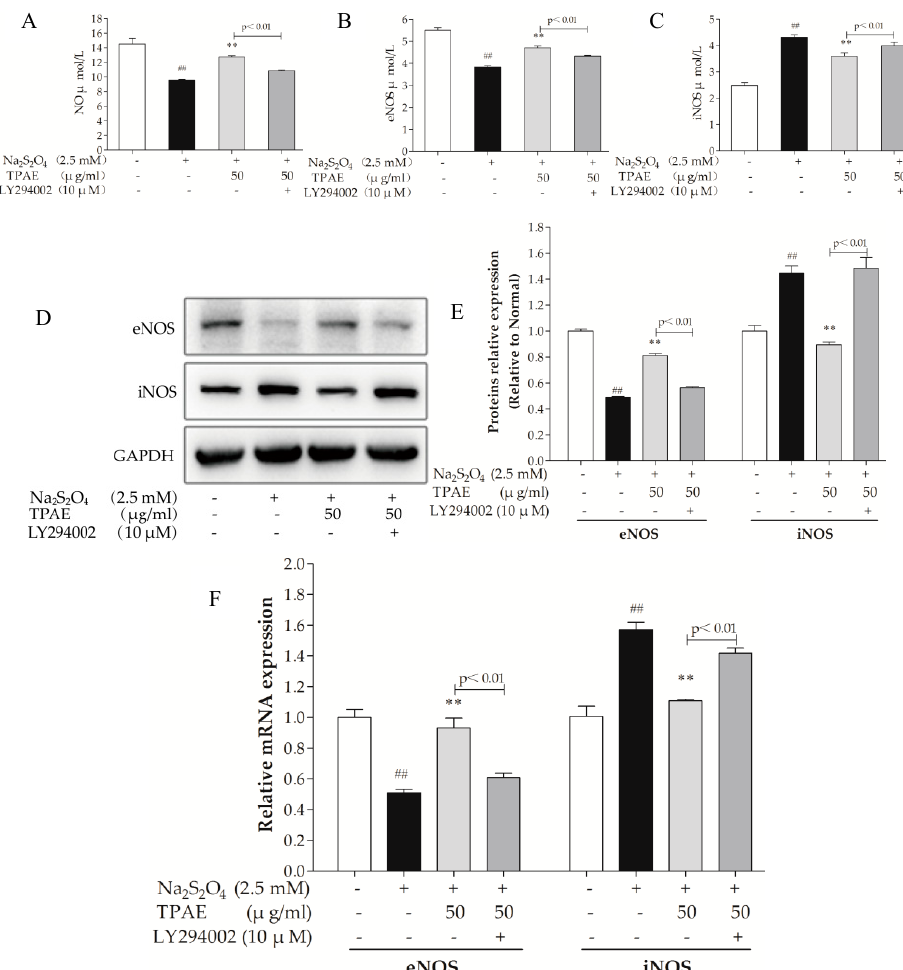
Figure 5. Effects of TPAE on NO, eNOS and iNOS levels. The amount of NO release ( A ), eNOS ( B ) and iNOS ( C ) activities were determined by ELISA kits. ( D ) The protein expression of eNOS, iNOS and GAPDH was measured by western blotting; ( E ) Quantitative analyses of eNOS and iNOS in protein expression were evaluated; ( F ) The relative mRNA expression of eNOS and iNOS was detected by qRT-PCR. Values were represented as mean ± SD (n = 3 for western blot and qRT-PCR, n = 8 for ELISA, each group). The results were representative of three independent experiments. # p < 0.05, ## p < 0.05 vs. normal group; * p < 0.05, ** p < 0.01 vs. H/R group.